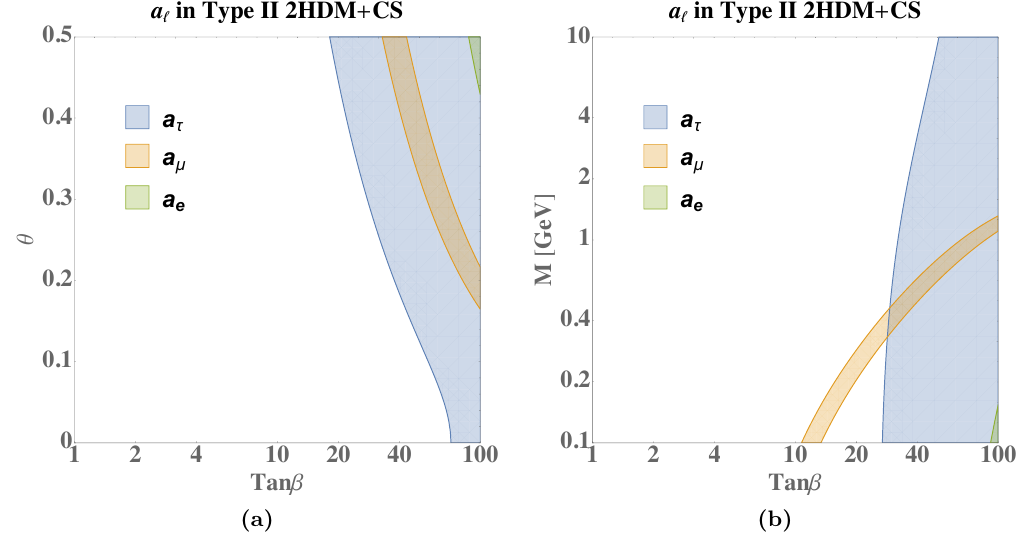
Figure 11 . The 95% exclusion from the g -2 measurement in 2HDM+CS model in tan (cid:12) { (cid:18) plane (a) where the extra scalar masses are (cid:12)xed at 1 GeV, and in tan (cid:12) { M plane (b) where (cid:18) is (cid:12)xed to be 0.25. The blue and green regions are excluded by the (cid:28) and e measurement respectively. The orange band is the region that could explain the muon g -2